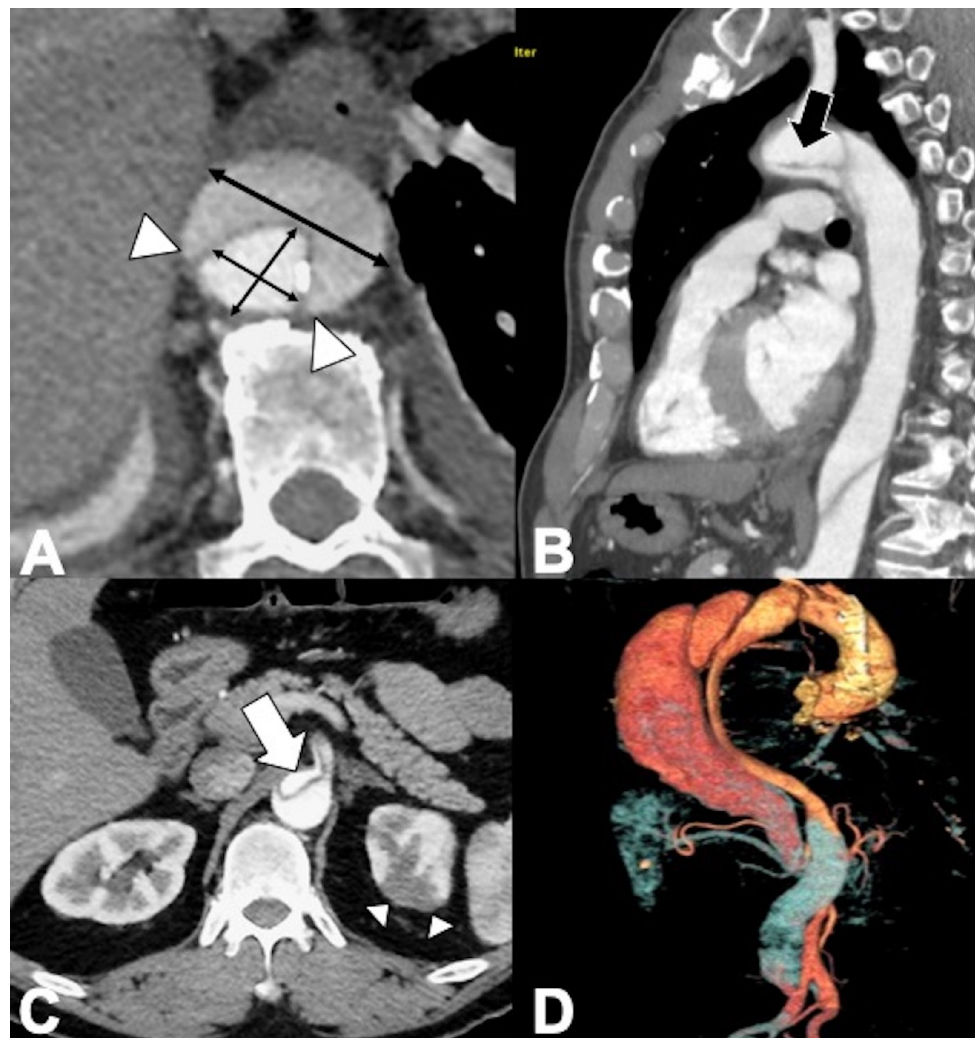
Figure 6. CTA findings in classic dual-barrel aortic dissection. ( A ) Axial CTA images showing the “beak sign” (arrowheads) in the false lumen because its wall and intimomedial flap usually form acute angles resembling a bird’s beak. In the radiological report, maximum aortic diameter and minimum and maximum aortic true lumen diameter should be included. ( B ) Sagittal oblique MPR image of non-A-non-B dissection with descending-entry and retrograde arch extension (arrow) in a 75-year-old male presenting with acute chest pain. ( C ) Axial CTA images. Static aortic dissection is seen as protrusion of the intimal flap (arrow) into the ostium of the affected branch vessel causing subsequent partial or total thrombosis of the branch vessel with resulting perfusion impairments. Note left kidney partial infarct (arrowheads). ( D ) CTA oblique coronal VR reconstruction image shows a three lumina aortic dissection.